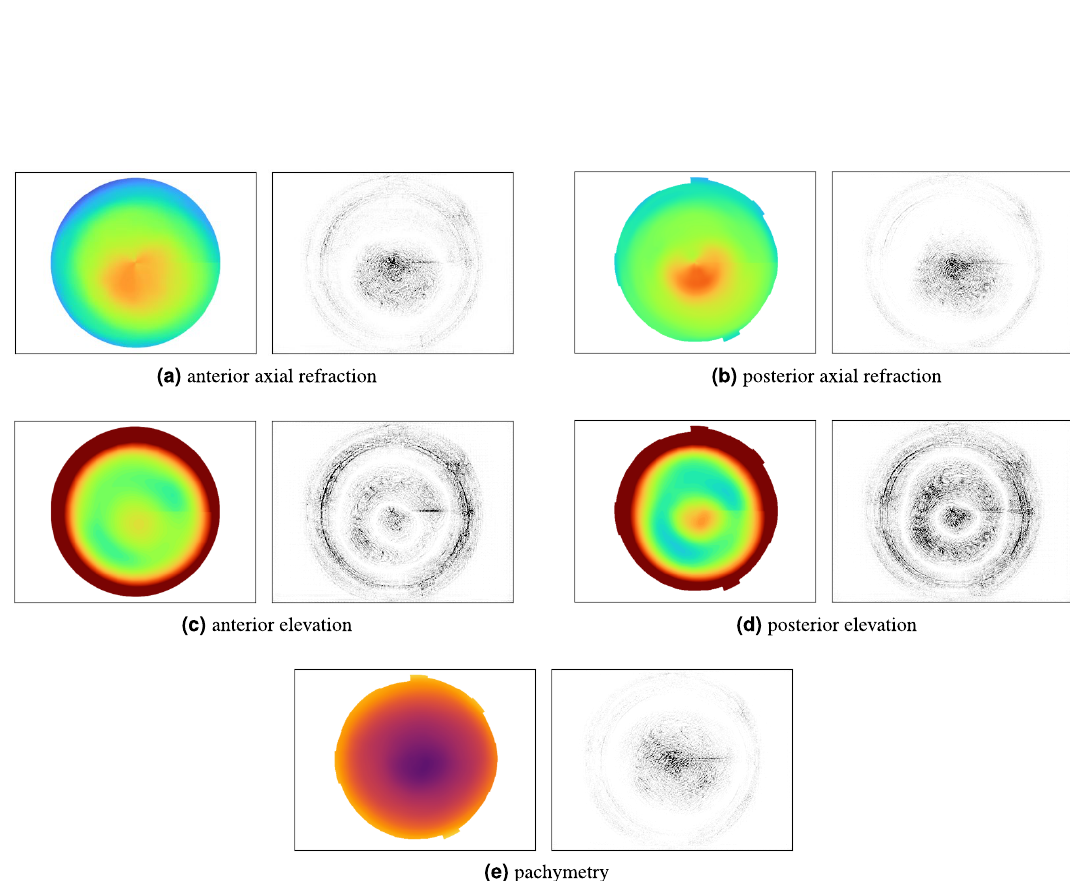
Figure 4. The computed integrated gradients with respect to the correct prediction keratoconus (88.9% confidence). A pixel highlighted in black means, that this pixel was relevant for the prediction